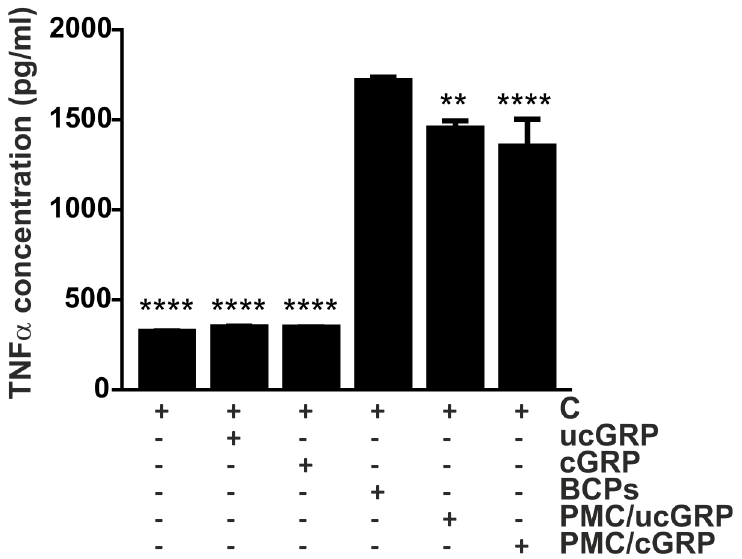
Fig 6. Coating of BCPs with GRP reduces TNF α production in THP-1 MoM when compared with naked crystals. Differentiated THP-1 MoM cells were treated with 100 μ g/ml of BCP crystals or BCPs-coated with cGRP/ucGRP (PMC/cGRP; PMC/ucGRP) proteinsfor 24 h, and non-stimulated cells were used as control (C). Control non-stimulated cells were also treated with 1.5 μ g/ml of cGRP/ucGRP proteinsfor comparison. Conditioned media were collectedand used to determineTNF α accumulation through ELISA assays. Data are presented as means (n = 3) ± standard error of triplicatesof two independent experiments. Ordinary one- way ANOVA was used and multiple comparisons were achievedwith Dunnett’s test. Statistical significance was definedas P < = 0.01 ( ** ) and P < 0.0001( ****